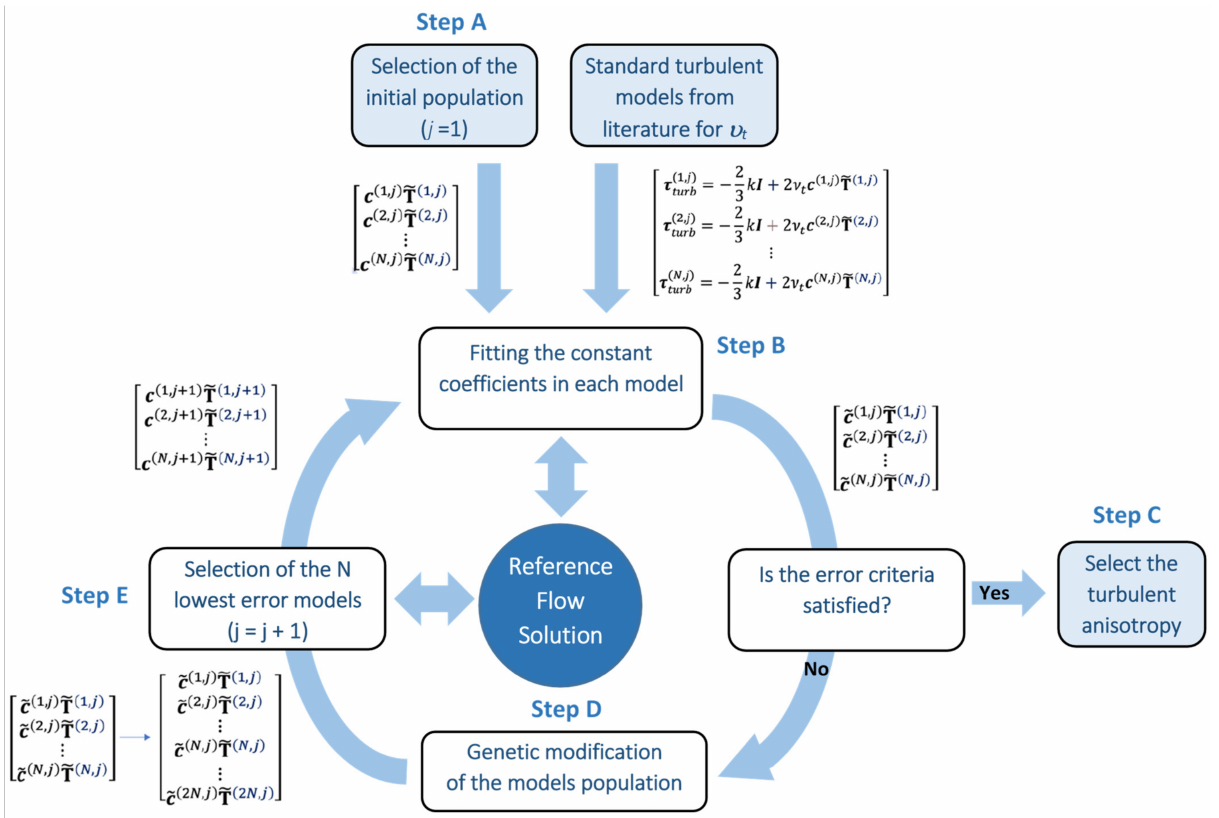
Figure 2. Schematic diagram of the optimization process to find an expression for the turbulent anisotropy tensor. This process is called structurally optimization of the turbulent anisotropy